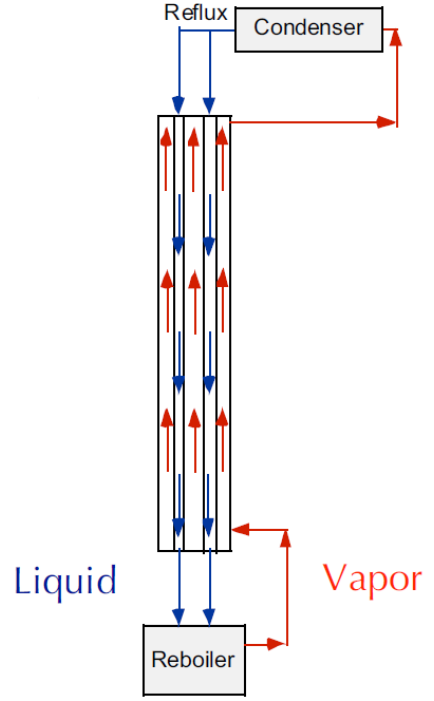
Figure 10. Distillation column with hollow fiber membranes as structured packings at total reflux condition (adapted from [159]).